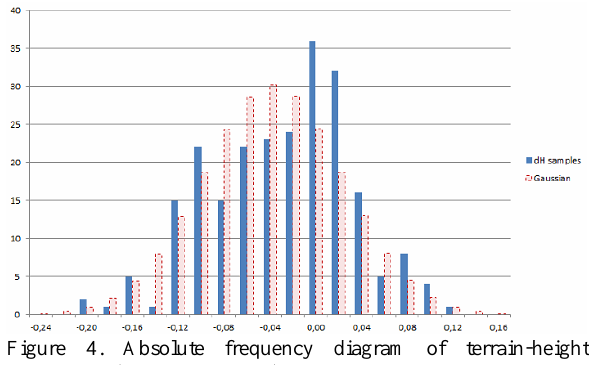
Figure 4. Absolute frequency diagram of terrain-height differences (DIM minus